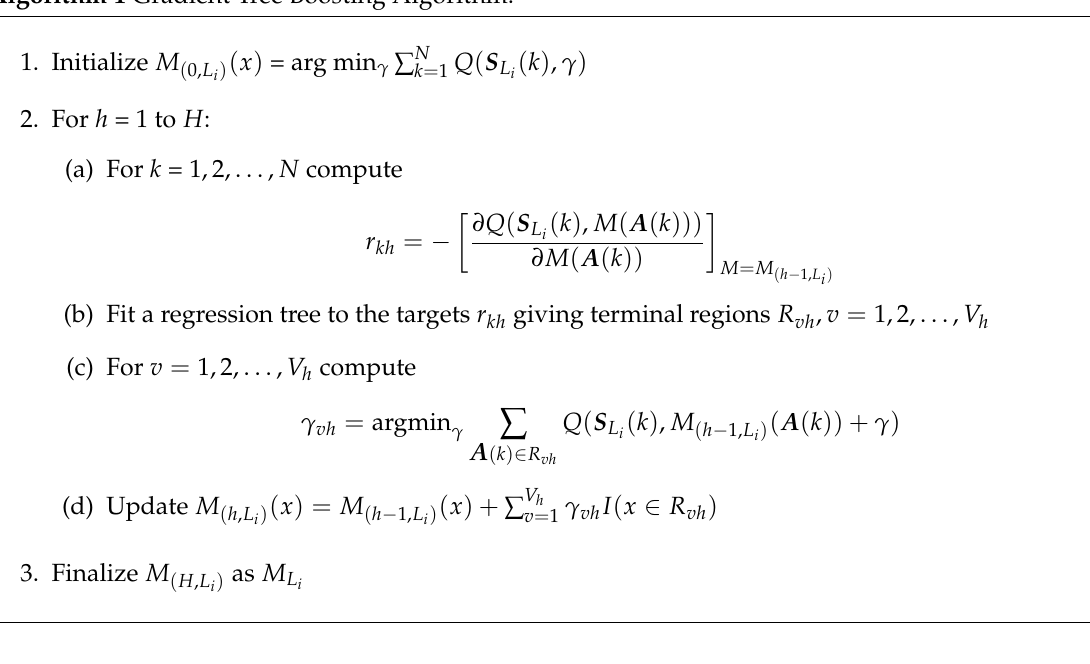
Algorithm 1. Algorithm 1 shows the case to construct the estimation model M L Algorithm 1 Gradient Tree Boosting